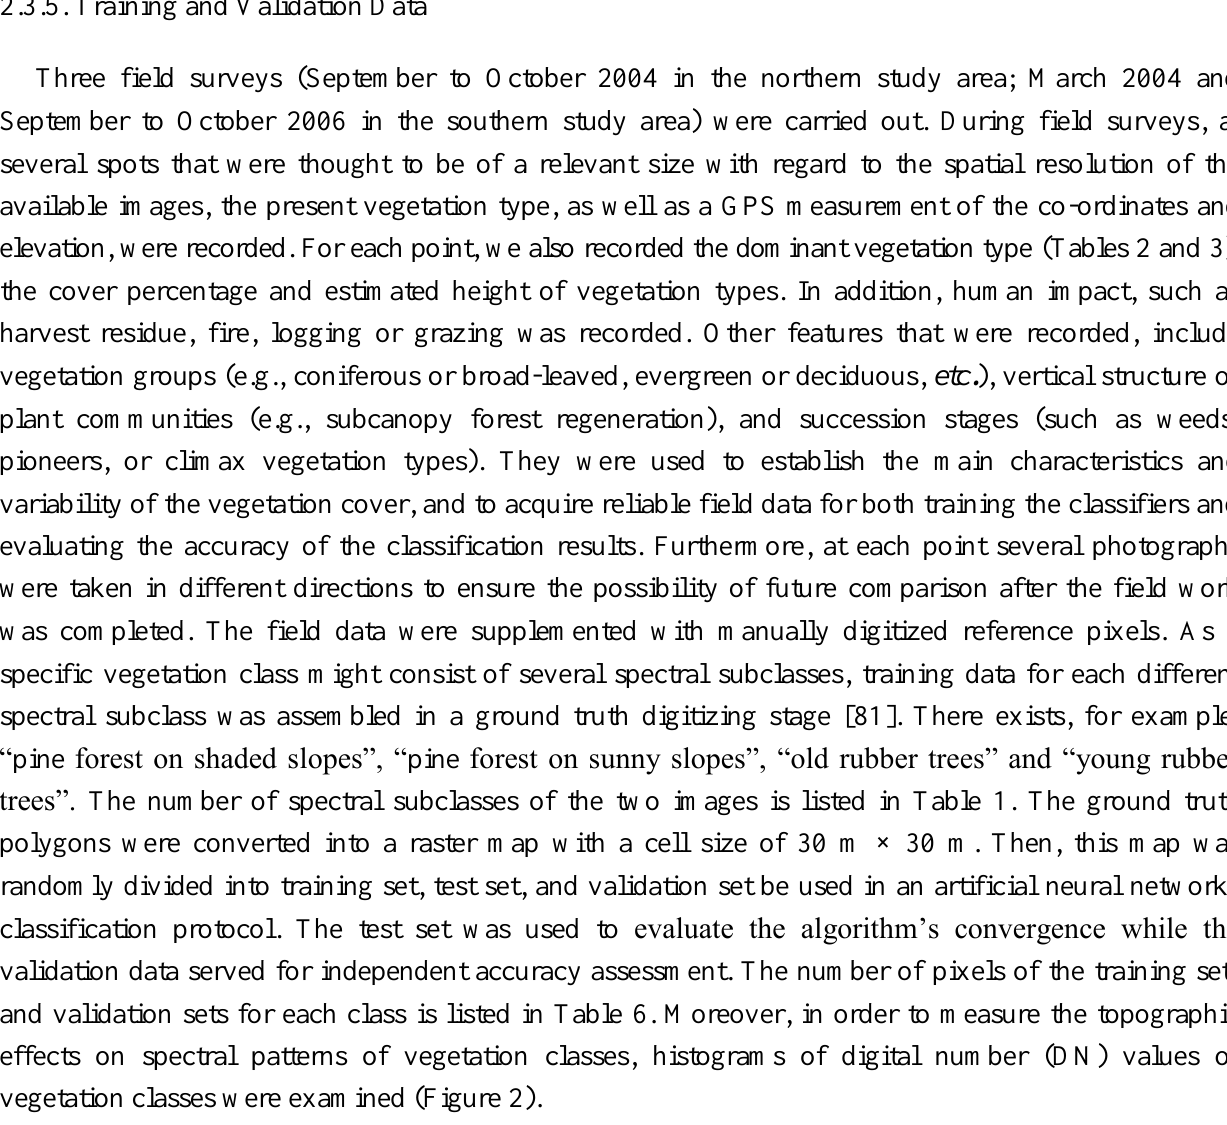
Table 6. The number of pixels of the training and validation sets for each class in the both study areas. The Northern Study Area The Southern Study